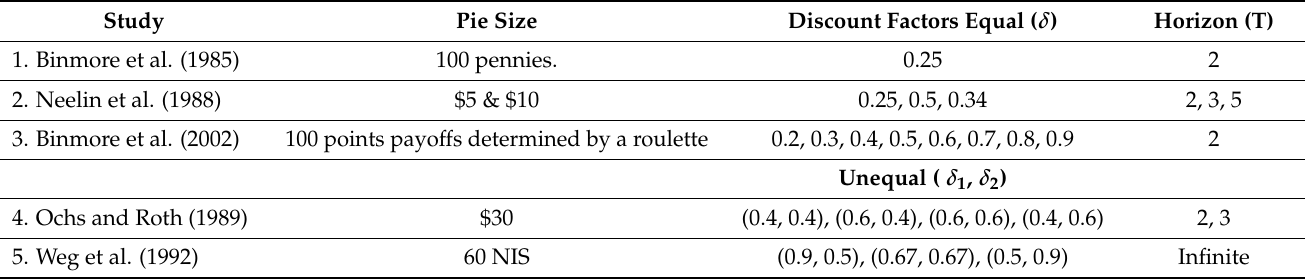
Table 1. Experimental conditions of the five investigated studies.